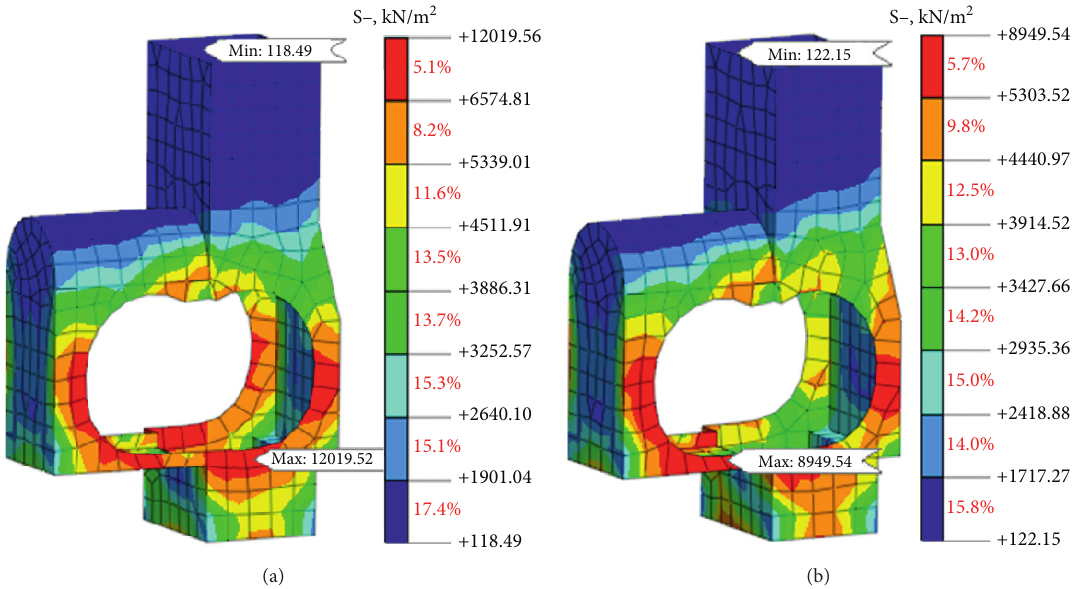
Figure 17: Shear stress distribution of support structure of shaft cross passage (unit: kN/m 2 ): (a) original scheme and (b) optimization